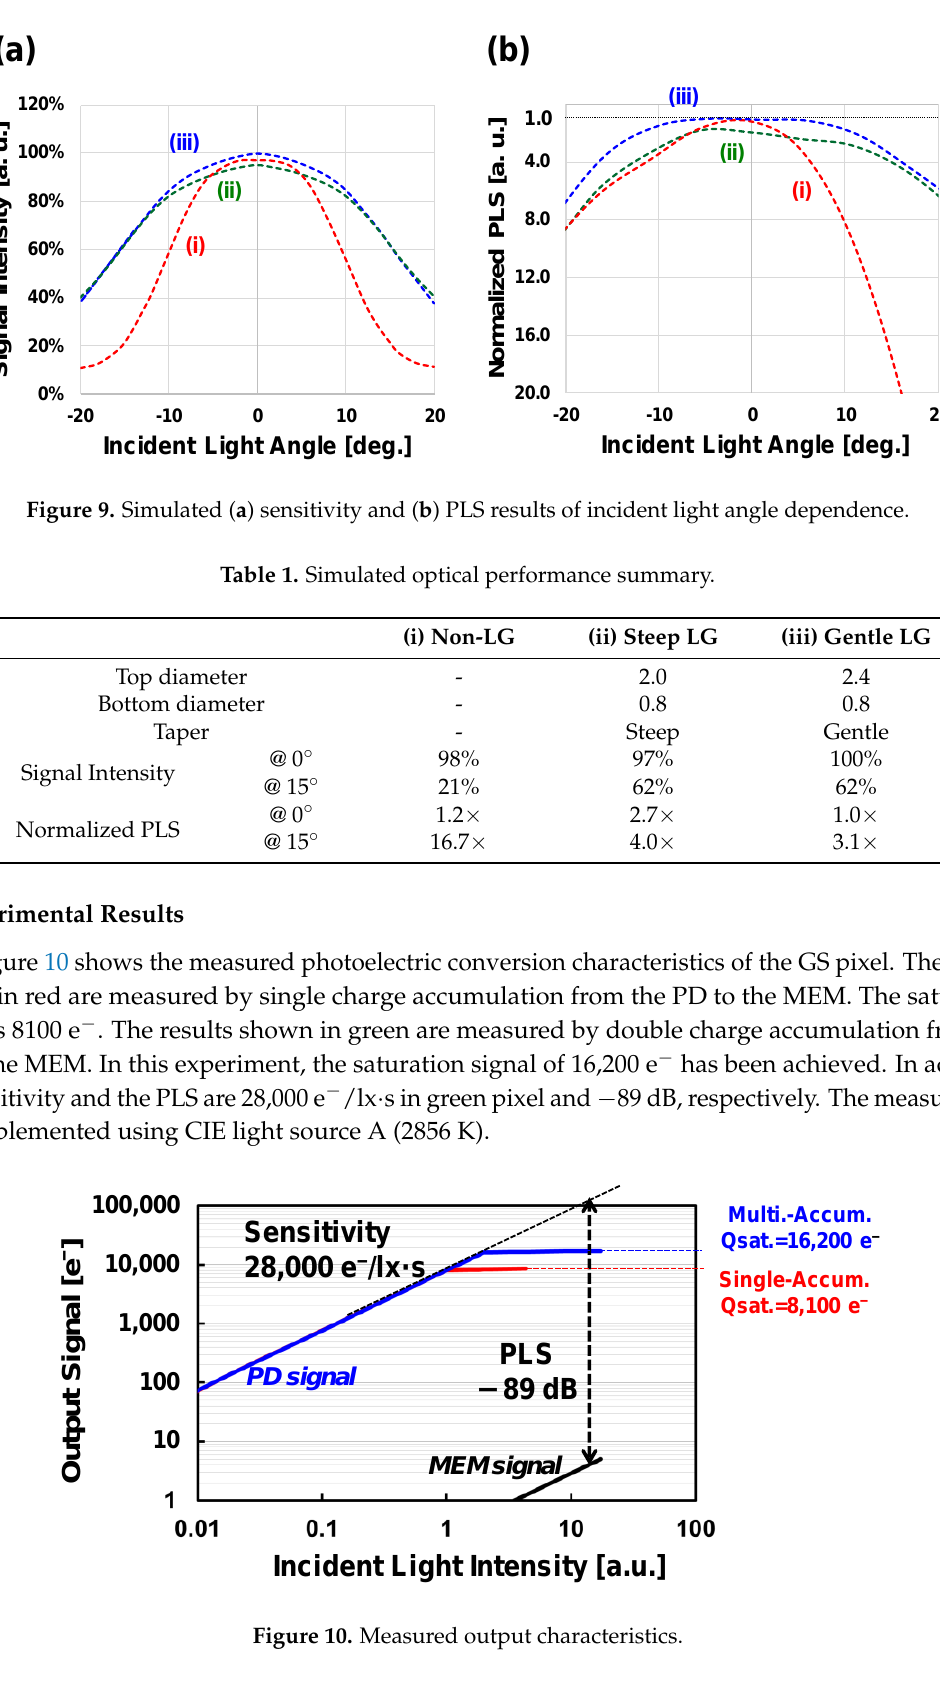
Figure 11. Measured output characteristics. Figure 12a shows the quantum efficiency (QE) spectrum of red, green, blue and white pixels. The sensitivity of the red color region is sufficient in spite of the small photodiode aperture. Figure 12b shows the incident light wavelength dependence of PLS. Although the PLS generally drops off at the longer wavelength region, the developed GS pixel keeps higher PLS even in the NIR region. This result is important for automotive, industrial and other emerging applications. Figure 13a shows the measured and simulation results of the incident light angle dependence of sensitivity with and without light guide structure normalized to sensitivity of perpendicular light. These results indicate that the ratio of 15° incident light to the perpendicular light has been improved from 21% to 62% by the effect of the light guide structure. Figure 13b shows the measured and simulation results of the incident light angle dependence of PLS with and without light guide structure normalized to PLS of perpendicular light. These results indicate that the ratio of 15° incident light to the perpendicular light has been improved from 16.7× to 3.1× by the effect of the light guide structure.